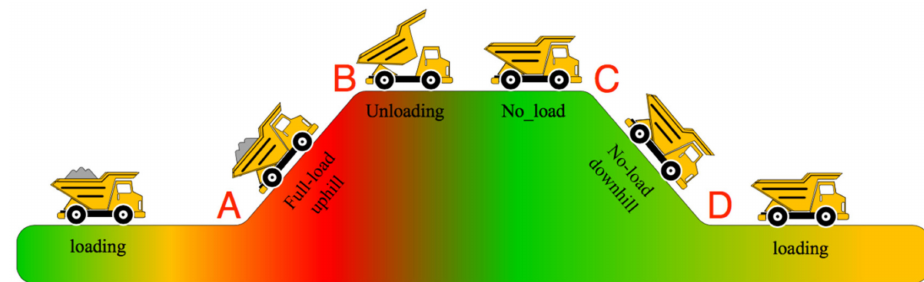
Figure 7. The transportation route of the mining truck [2].